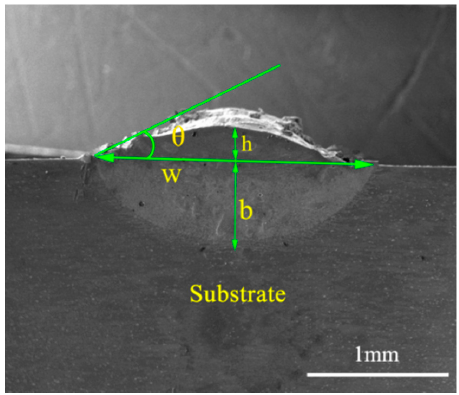
Figure 1. A schematic view of typical laser track with its main geometric features.